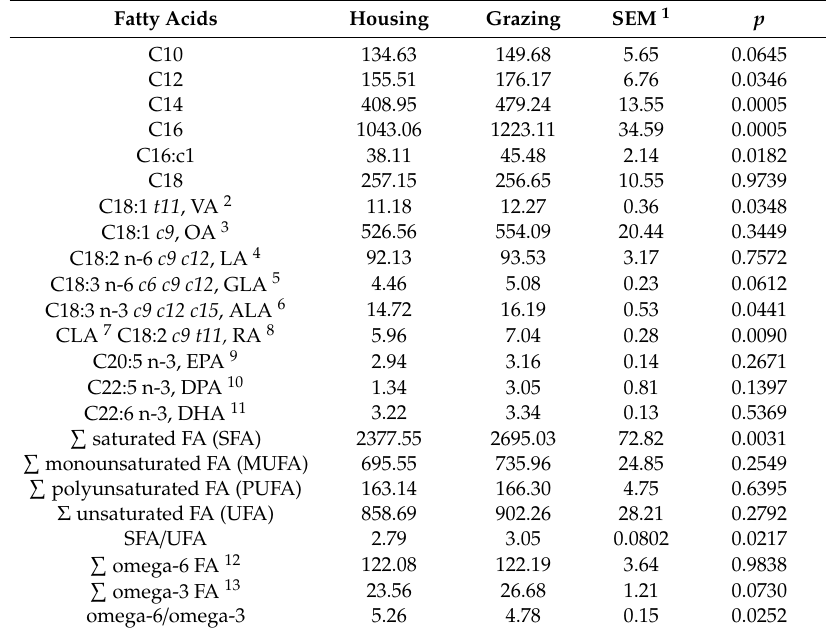
Table 5. E ff ect of feeding system on the fatty acid (FA) content of individual cow milk (mg / 100 g milk). Fatty Acids Housing Grazing